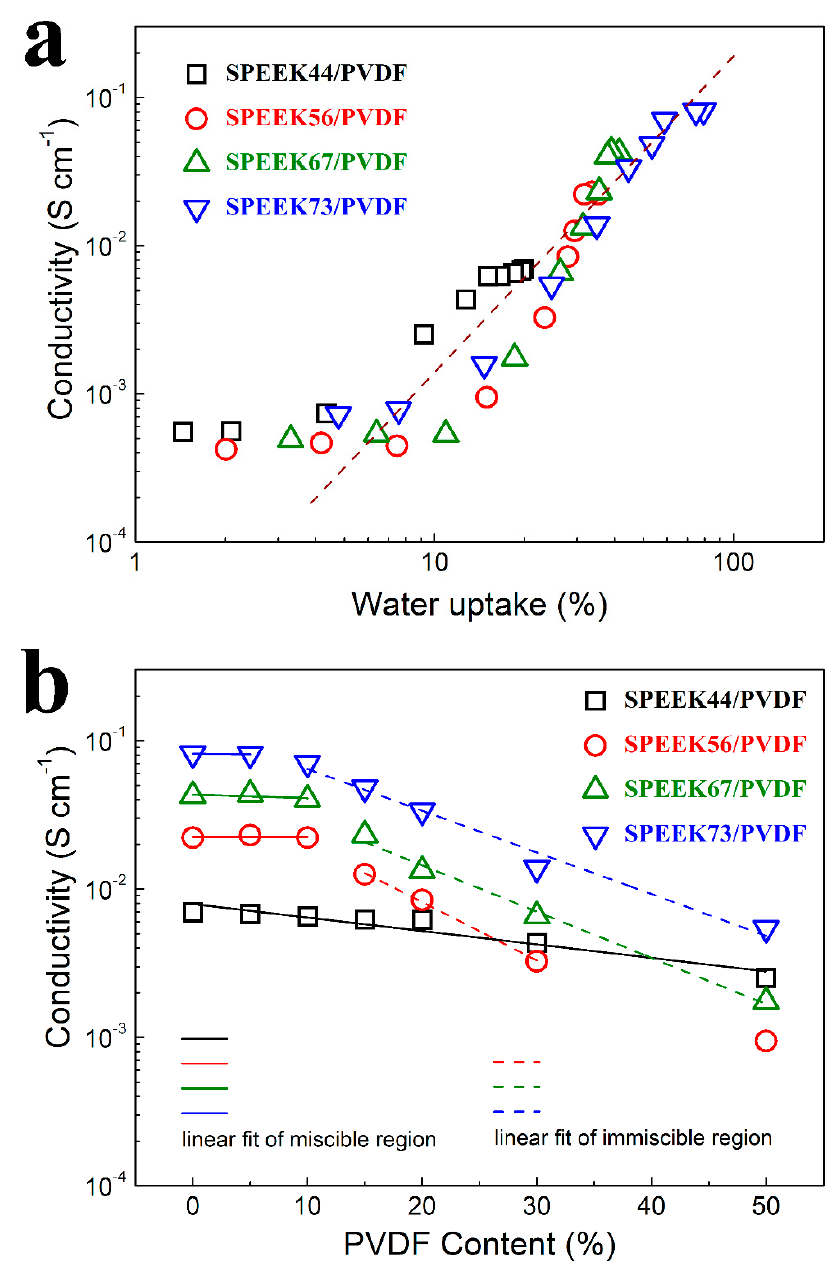
Figure 5. Proton conductivity as a function of ( a ) water uptake and ( b ) PVDF content for SPEEK / PVDF blend membranes.